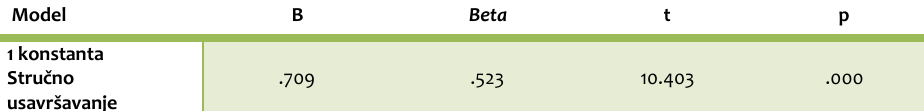
Tabela 8. Prikaz doprinosa stručnog usavršavanja za predikciju odnosa prema društvenim sadrž ajima u